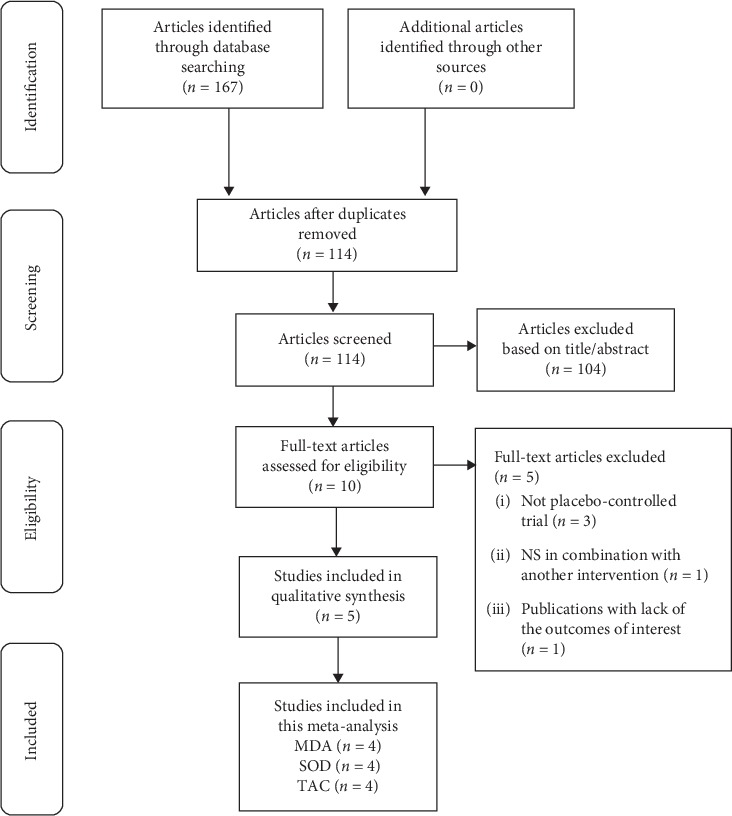
Flow diagram of the number of studies included in the meta-analysis.